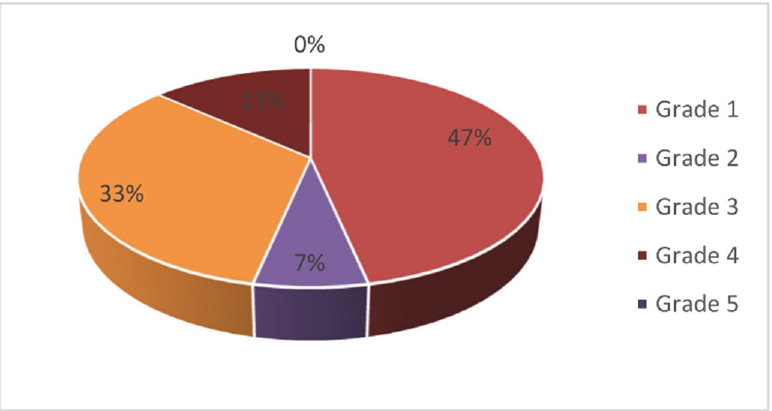
Figure 3. Distribution of histological tissue reaction grading: 47% of samples were at grade 1; 7% at grade 2; 33% at grade 3, 13% at grade 4, and 0% at grade 5.